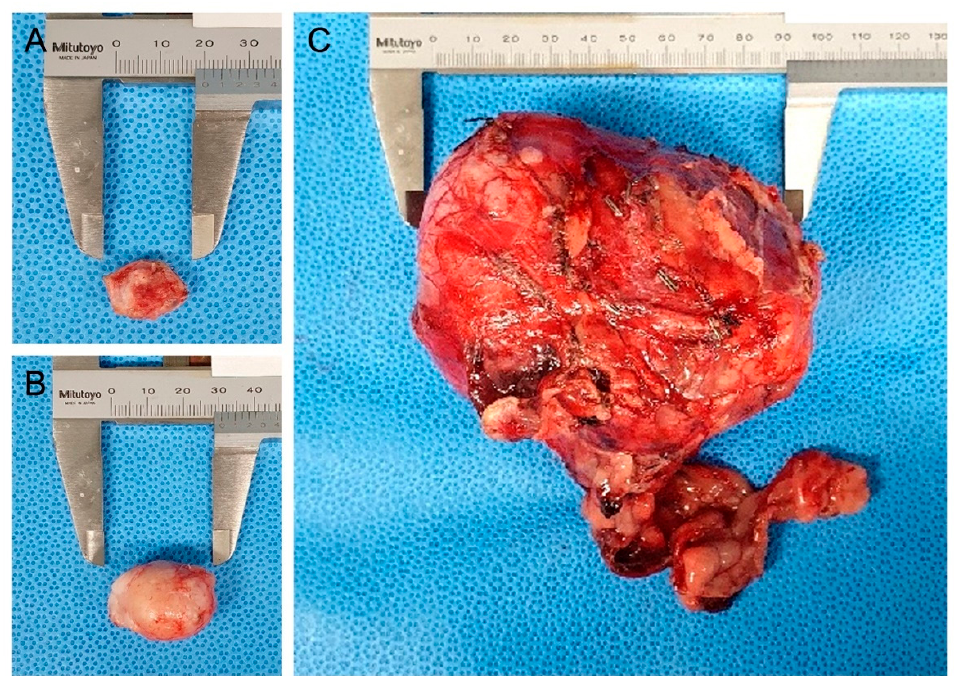
Figure 2. Gross appearance of the resected metatarsal skin mass, popliteal lymph node, and retroperitoneal mass: ( A ) right metatarsal region cutaneous mass resected with a 5 mm surgical margin; ( B ) resected enlarged right popliteal lymph node; ( C ) resected retroperitoneal mass.